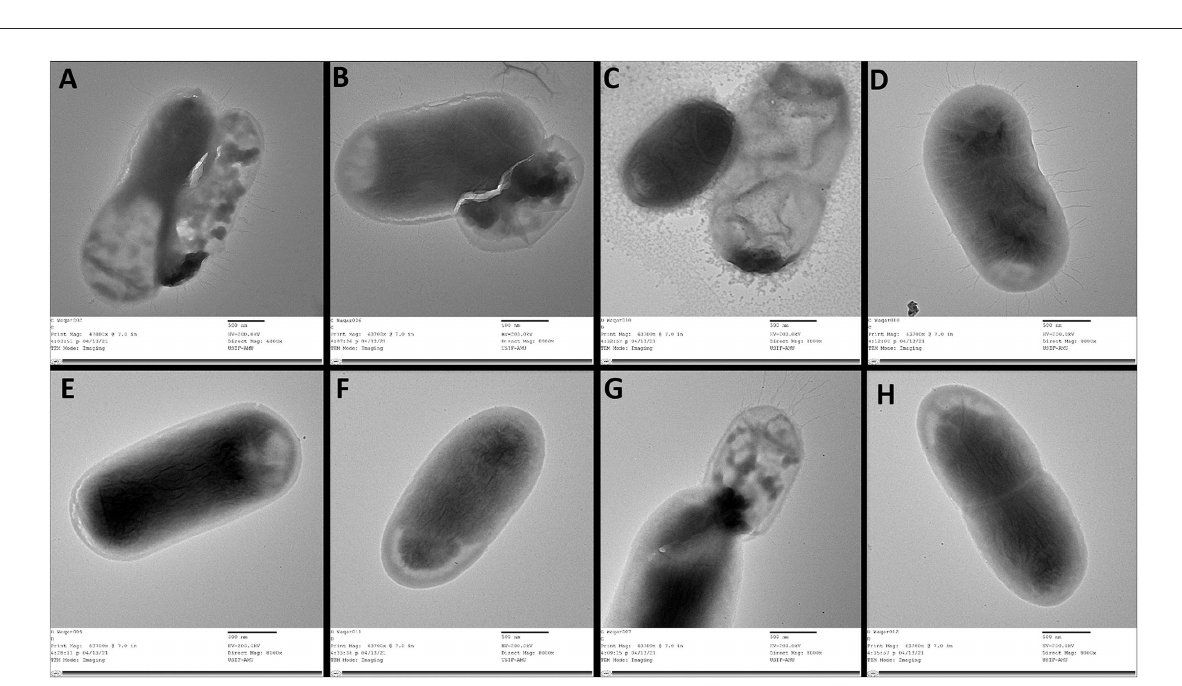
or directly exposed to the bacterial cell surface. A majority of the adhesins are encoded by the pathogenicity islands (PAIs) (30). Fimbriae (pili) are filamentous structures that help bacterial cell